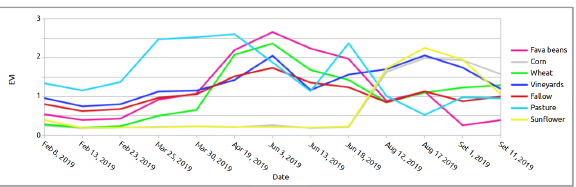
Table 7. Time series of S2 acquired during in the italian agricultural period. ‘x’= included